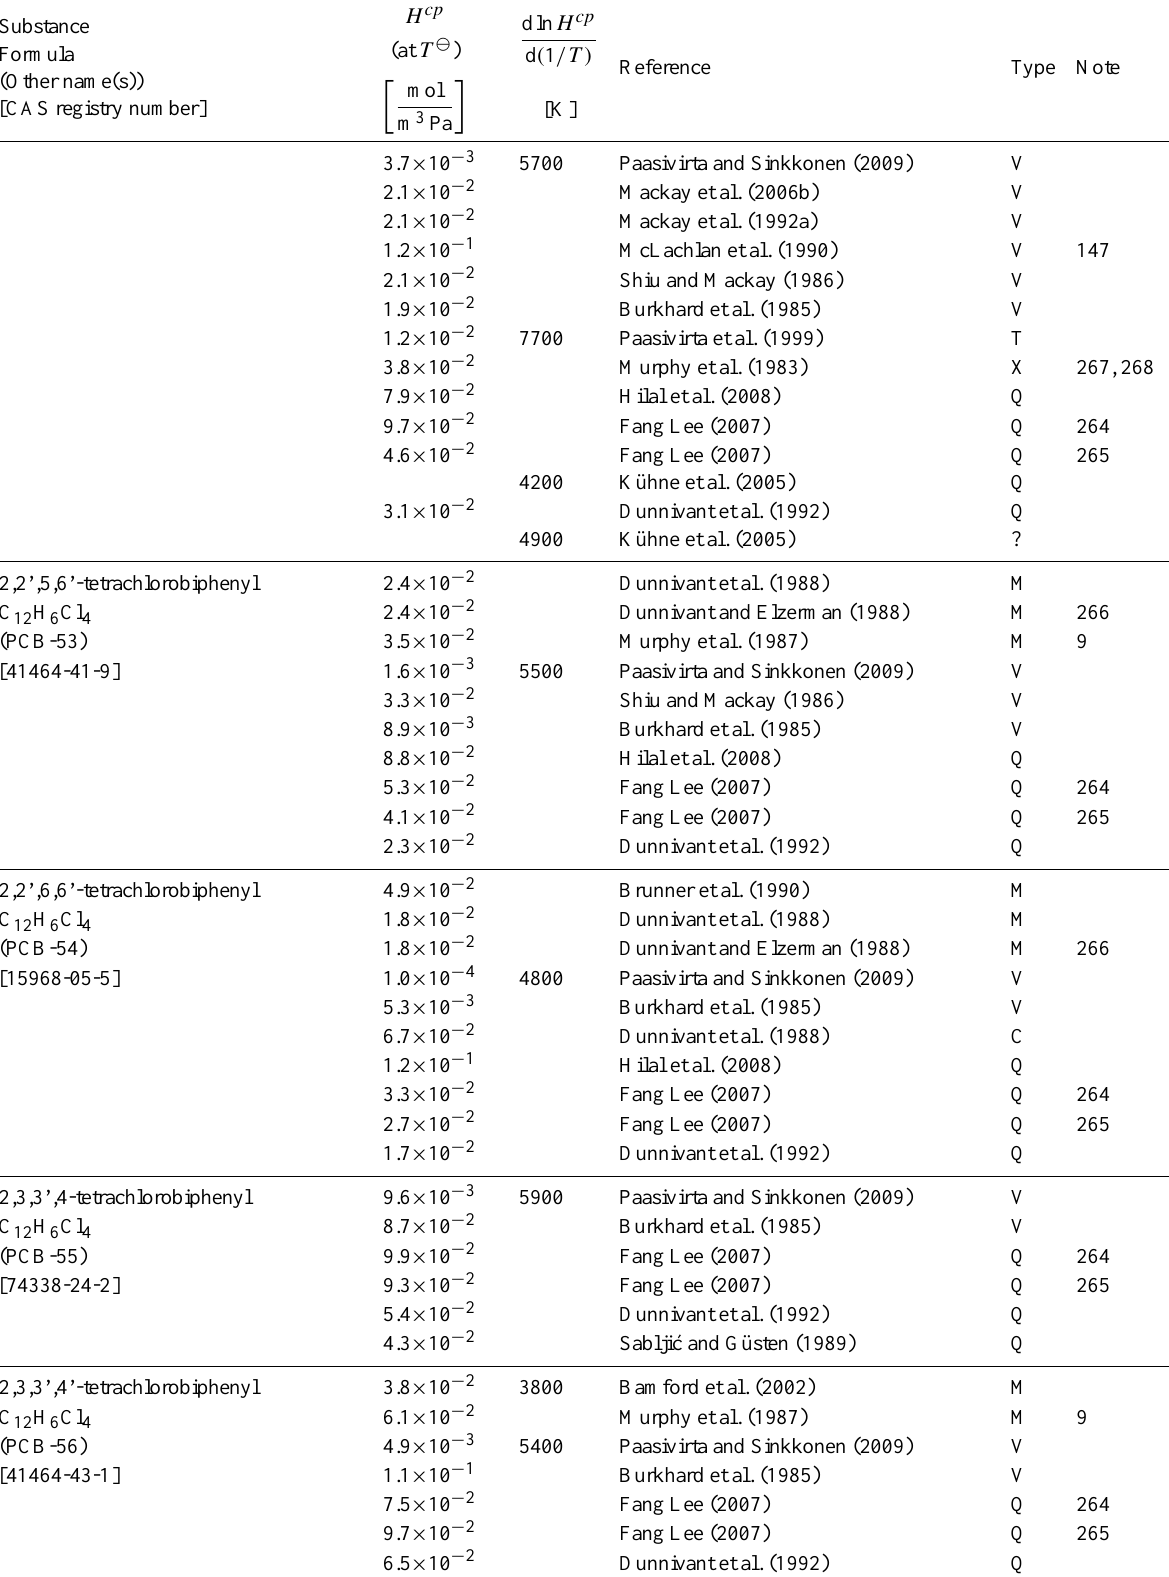
Table 6: Henry’s law constants for water as solvent